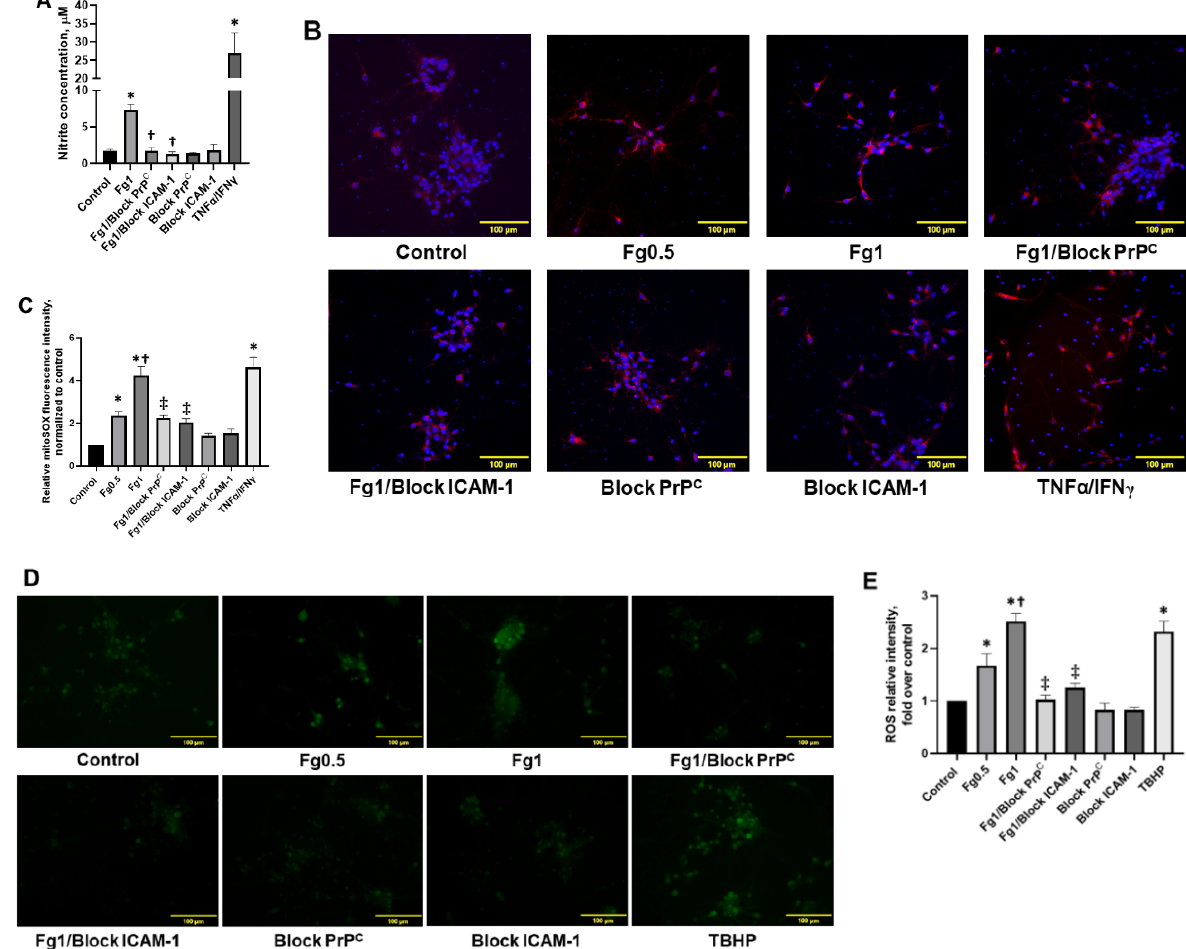
Figure 4. Fibrinogen (Fg)-induced production of nitrite, mitochondrial superoxide, and the generation of reactive oxygen species (ROS) in neurons. The cells were treated for 2 h with medium alone (control), 0.5 mg/mL of Fg, 1 mg/mL of Fg, 1 mg/mL of Fg in the presence of a cellular prion protein (PrP C )-blocking peptide (Fg1/block PrP C ), 1 mg/mL of Fg in the presence of a function-blocking antibody against intercellular adhesion molecule-1 (ICAM-1) (Fg1/block ICAM-1), the prion protein-blocking peptide alone, or the ICAM function-blocking antibody alone. Hirudin was present in all experimental groups to prevent the conversion of Fg to fibrin. ( A ) The graph depicts the concentration of nitrite measured in media collected from treated neurons using a Griess assay. The experimental group with tumor necrosis factor alpha (TNF α ) co-stimulated with interferon gamma (IFN γ ) was used as a positive control (TNF α /IFN γ ). ( B ) Representative images show superoxide production by neuronal mitochondria detected via mitoSOX (red). In these experiments, TNF α /IFN γ was used as a positive control as well. Cellular nuclei were labeled with 4 ′ ,6-diamidino-2-phenylindole (blue). ( C ) The summary of the image analyses for the detection of Fg-induced mitochondrial superoxide generation in neurons. ( D ) Representative images show ROS generation by neurons. Tert -butyl hydroperoxide (TBHP), a common inducer of ROS production, was used as a positive control in this assay. ( E ) The summary of image analyses for the detection of Fg- induced ROS generation in neurons. p < 0.05 in all; ∗ —vs. Control, †—vs. Fg0.5 and ‡—vs. Fg1; n = 4.